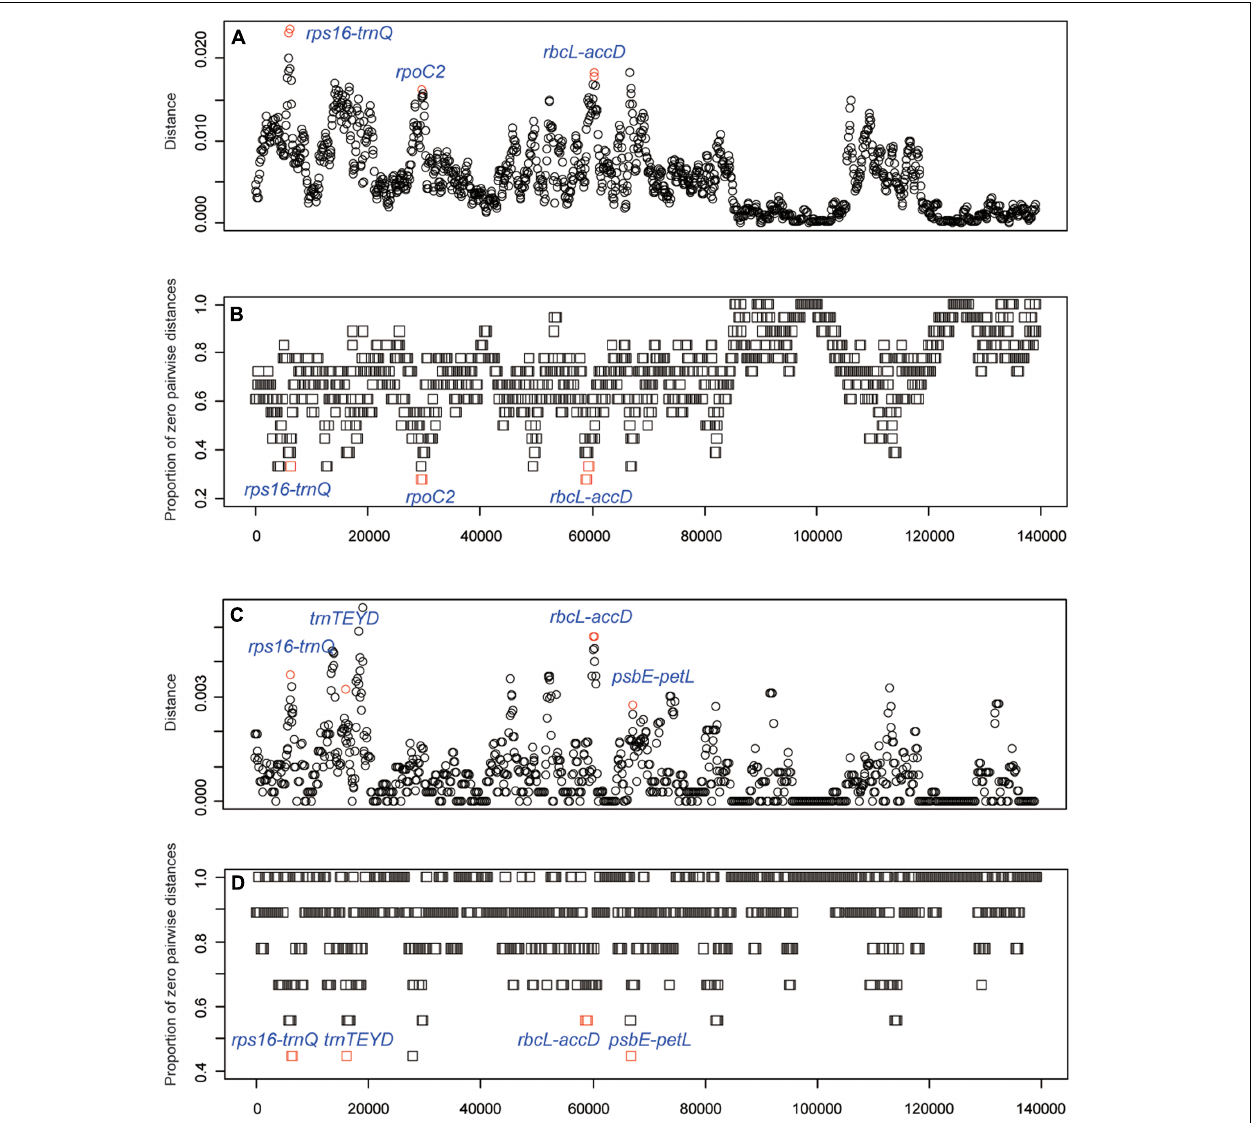
FIGURE 5 | DNA barcode development. (A) Mean distance of each window using the 18 species data set. (B) The proportion of zero pairwise distances for each species based on the 18 species data set. (C) Mean distance of each window using the AA genome species data set. (D) The proportion of zero pairwise distances for each species based on the AA genome species data